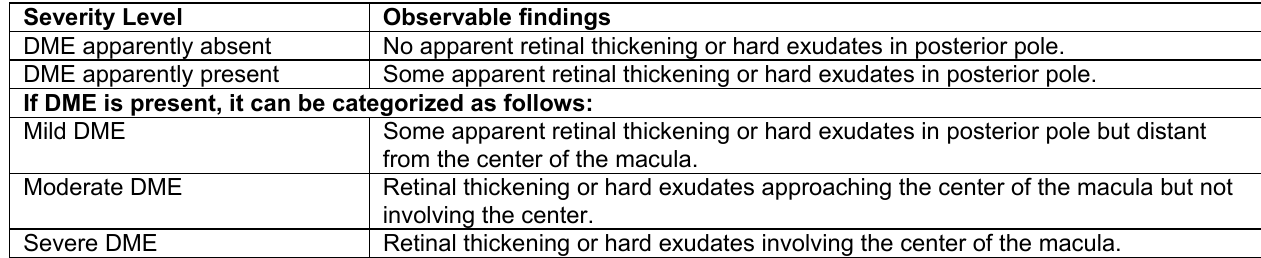
Table 2. Classification of DME according to the DME Disease Severity Scale. (Reproduced with permission from Willkinson et al , and The Global Diabetic Retinopathy Project Group, 2003). Severity Level